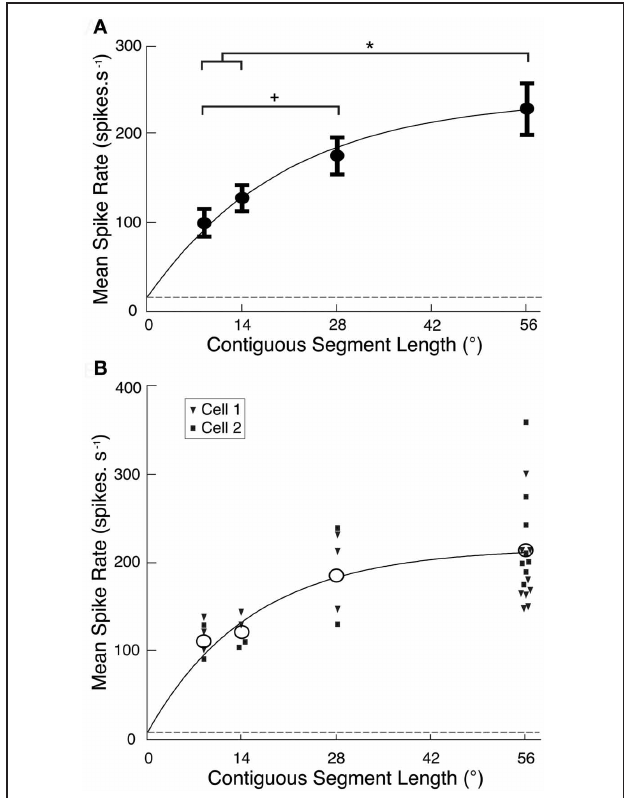
FIGURE 2 | (A) CSTMD1 spike rate averaged over each reconstructed ROI ( Figure 1C ) from the segment length variants (mean ± SEM, n = 6 neurons). As segment length increases, overall activity increases at a decreasing rate (grey line, exponential curve fit). Though the target crosses many ommatidia at all segment lengths, the 56 ◦ single path produces significantly stronger CSTMD1 activity than either the 14 or 9 ◦ segment lengths ( ∗ P < 0 . 05). Additionally, responses to the 28 ◦ two paths is significantly higher than the 9 ◦ six paths ( + P < 0 . 05). The dashed line indicates levels of spontaneous activity. (B) The mean spike rate averaged over the reconstructed ROI for each of the segment length variants in the newly described neuron, BSTMD1 (unfilled circles, mean, n = 2). Individual replicates of each segment length from each cell are represented as filled squares and triangles, respectively. Neuronal activity increases as segment length increases, in a similar manner to CSTMD1 ( Figure 2A